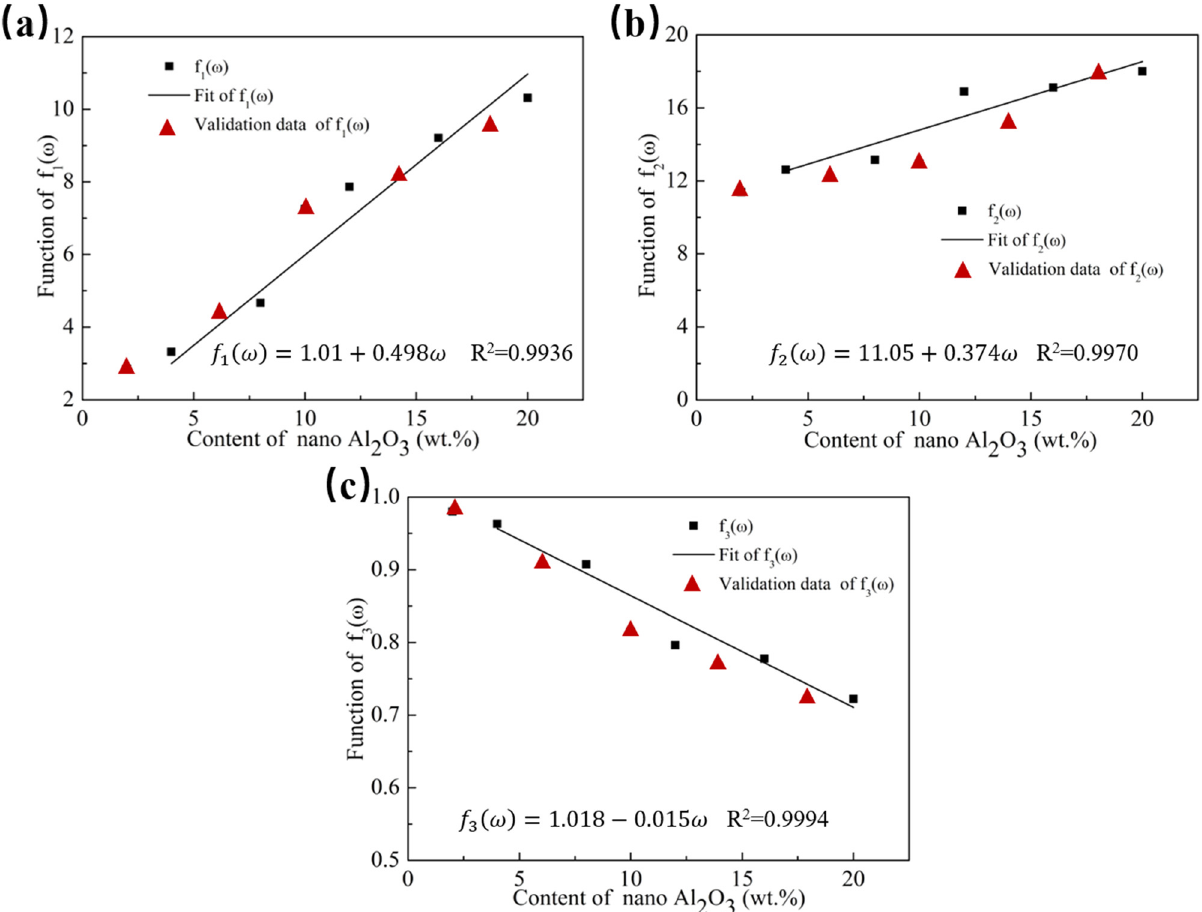
Figure 7: Carreau model parameters of the Al 2 O 3 /LLDPE composites as a function of nano Al 2 O 3 content: ( a ) ( ) f ω 1 , ( b ) ( ) f ω 2 , and ( c ) ( ) f ω